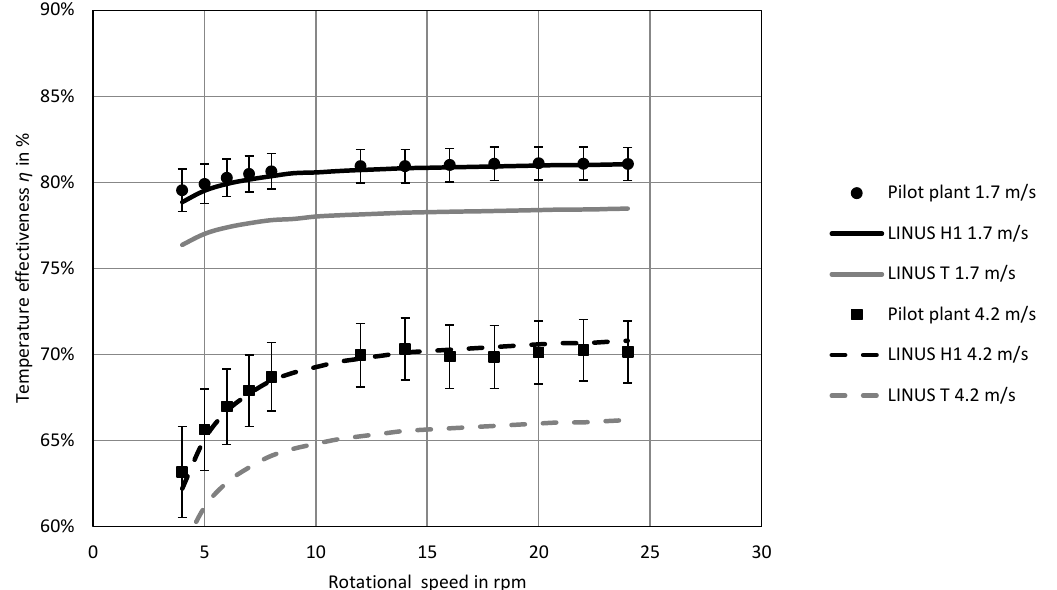
Figure 14. Results from pilot plant and simulation with the LINUS model.